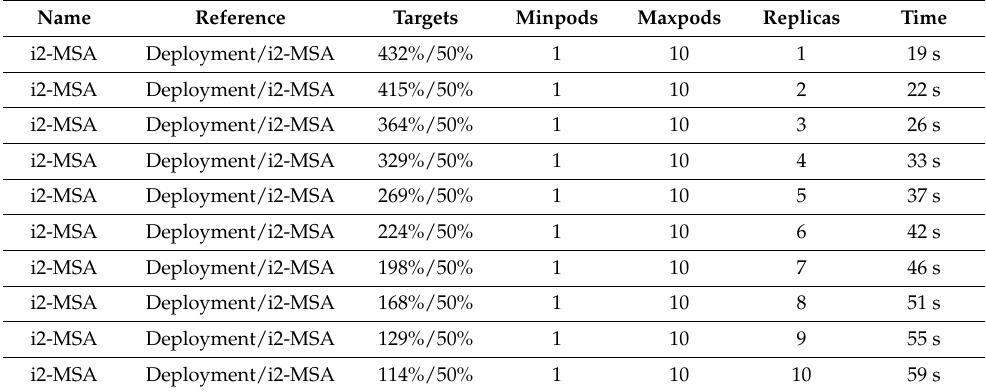
Table 4. Improved DQN-based auto-scaling performance test results.